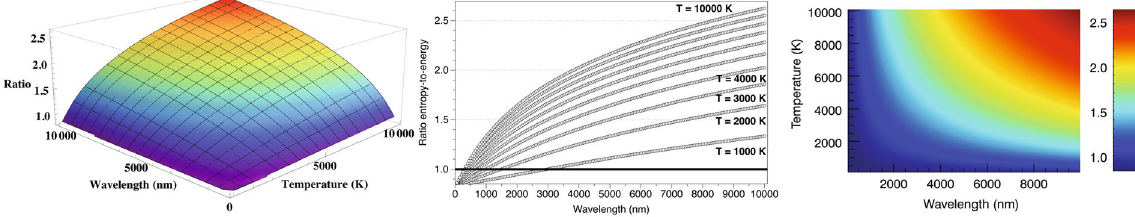
Figure 4. ( a ) (left): 3D plot of the ratio entropy-to-energy as a function of Wavelength and Temperature. ( b ) (center): Projection of the ratio entropy-to-energy in the Wavelength-Ratio space. ( c ) (right): Projection of the ratio entropy-to-energy in the Wavelength-Temperature space.